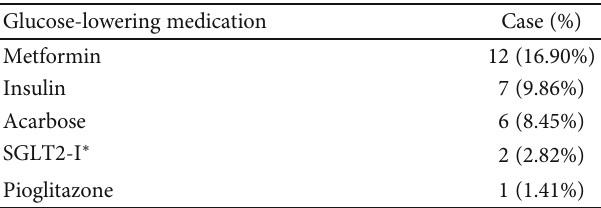
was performed when the data presented skewed distribution. One patient with DM died of severe heart failure and lactic acidosis after 11 h of admission. Another patient with lung cancer in the NDM group died of severe respiratory failure and refuse of trachea intubation on the 12th day after admission. Table 2: Glucose-lowering medication in patients of COVID-19 with